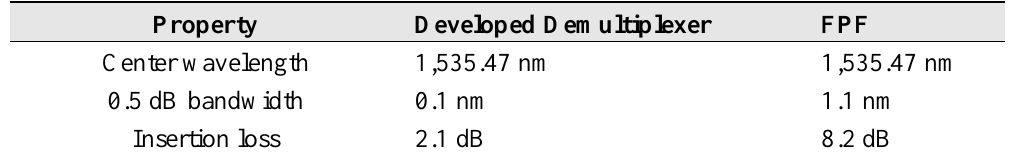
Table 1. Optical properties comparison of the fabricated FBG optical demultiplexer with FPF.